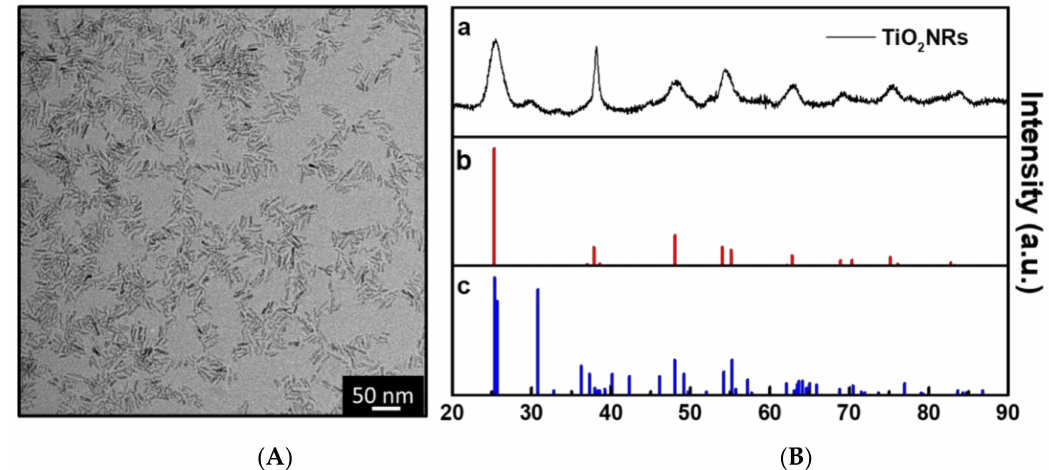
Figure 1. ( A ) The TEM micrograph of an OLEA-Capped TiO 2 NRs sample; ( B ) XRD experimental pattern of OLEA-Capped TiO 2 NRs sample (a) and Bragg hkl reflection for anatase (b) and brookite (c)